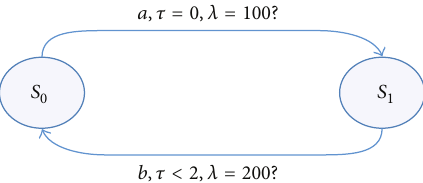
Figure 1: An example of time language.